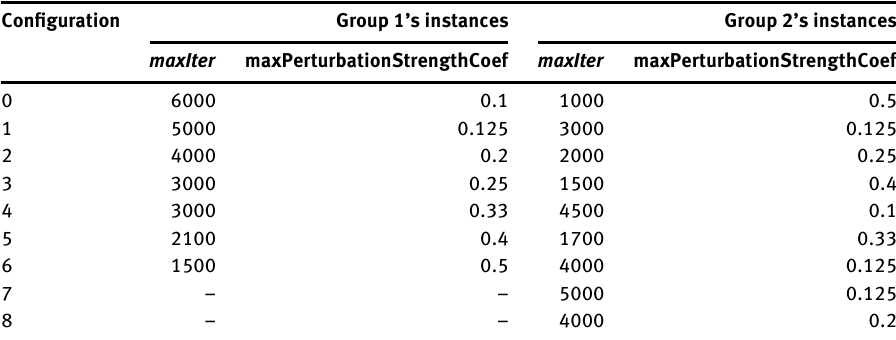
Table 3: Some Free Parameters Settings Tried During Enhanced ILS Tuning.